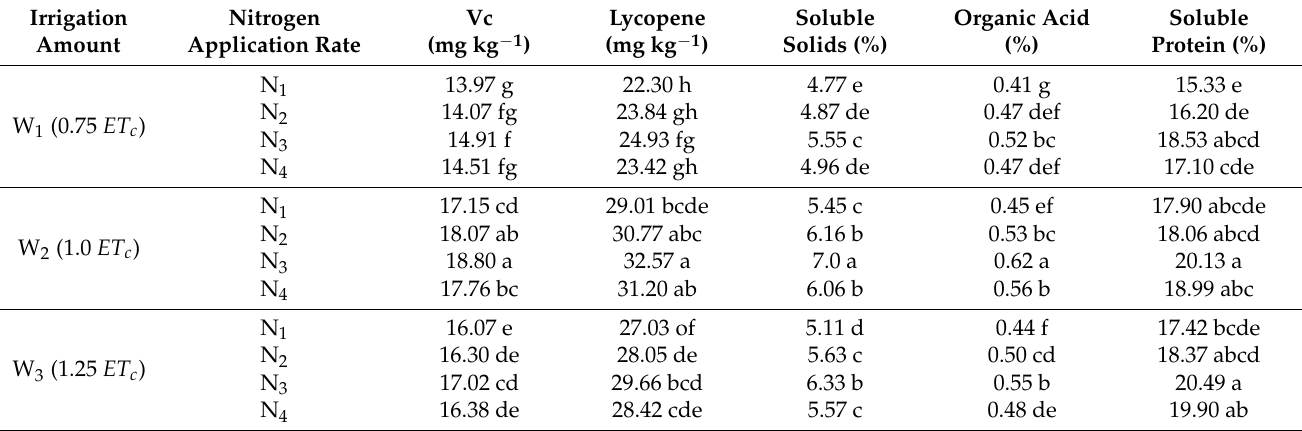
Table 5. Effects of different irrigation and nitrogen levels on fruit concentrations of vitamin C (Vc), lycopene, total soluble solids (TSS), organic acid and soluble